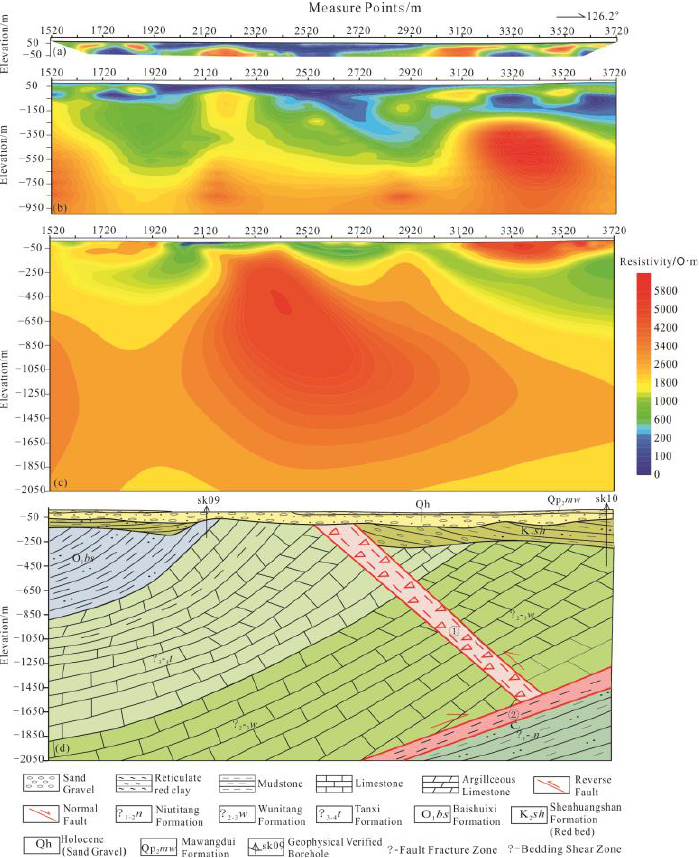
Figure 2. Geological interpretation of G4 test profile in the study area ( a ) High-density electrical processing results; ( b ) Controllable-source audio-magnetotelluric processing results; ( c ) Wide-area electromagnetic processing results; (d) Geological profile of G4.